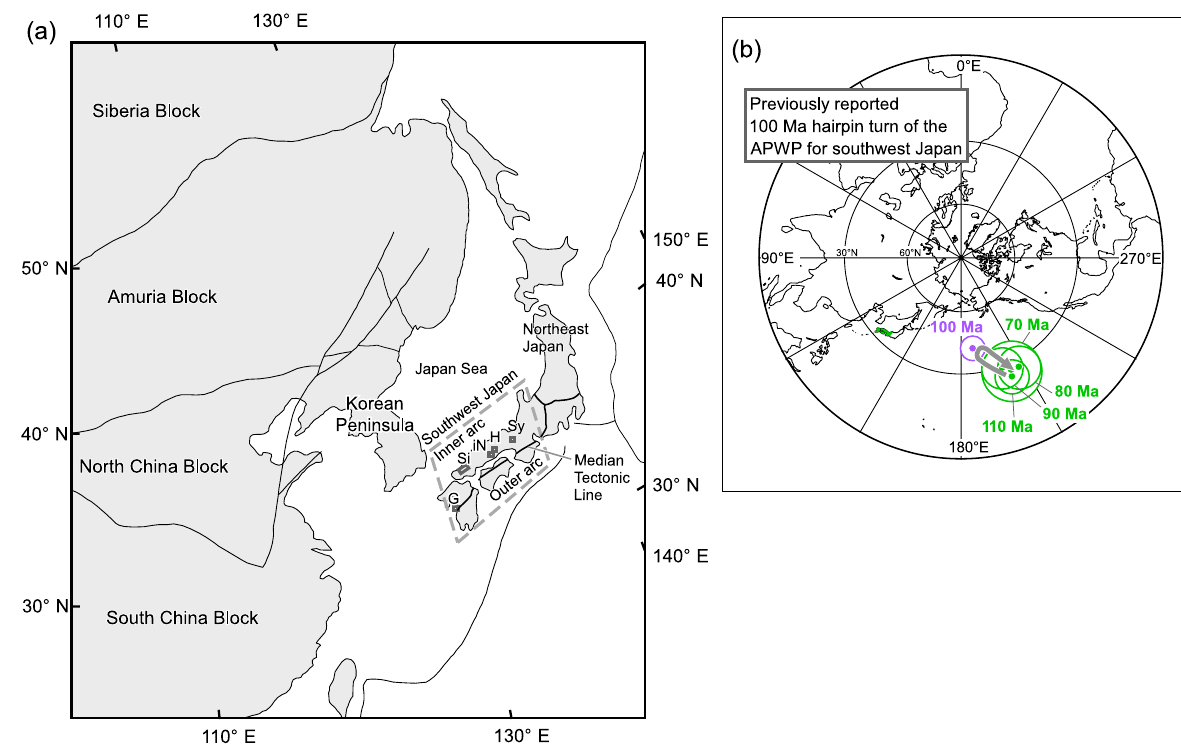
Fig. 1 a Tectonic outline map of East Asia and the Japan Arc. G Goshonoura area, Si San’in area, iN Inakura area, H Hayama area (study area), Sy Sasayama area. The Median Tectonic Line demarcates southwest Japan into the inner and outer arcs. b Previously proposed APWP for southwest Japan, except the 100 Ma pole (Uno et al. 2021). The 100 Ma pole (187.8°N and 40.6°E with A 95 study using data from Otofuji and Matsuda (1987) and Kodama and Takeda